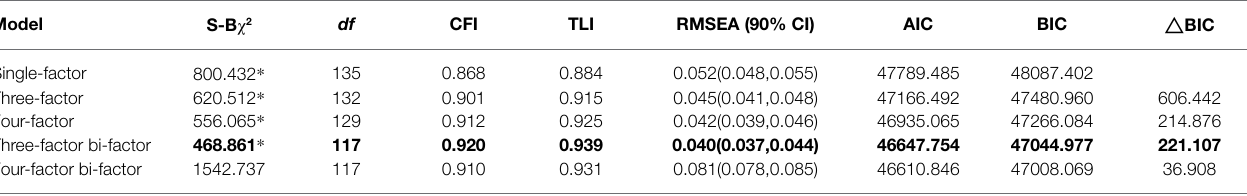
TABLE 3 | Goodness-of-fit indices for the five tested models of the BSI-18. Model